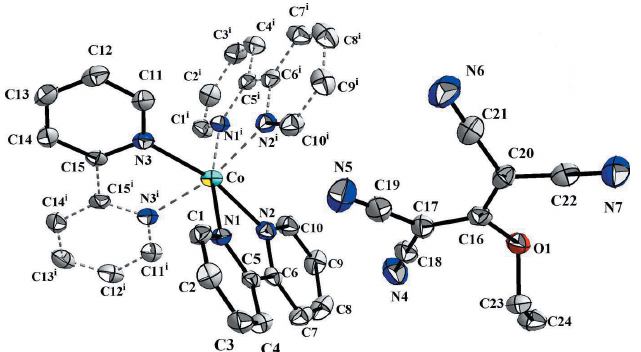
Figure 1 The independent components of compound (I), showing the atom- numbering scheme [symmetry code: (i) (cid:3) x + 1, y , (cid:3) z + 1 ellipsoids are drawn at the 50% probability level. The hydrogen atoms have been omitted for